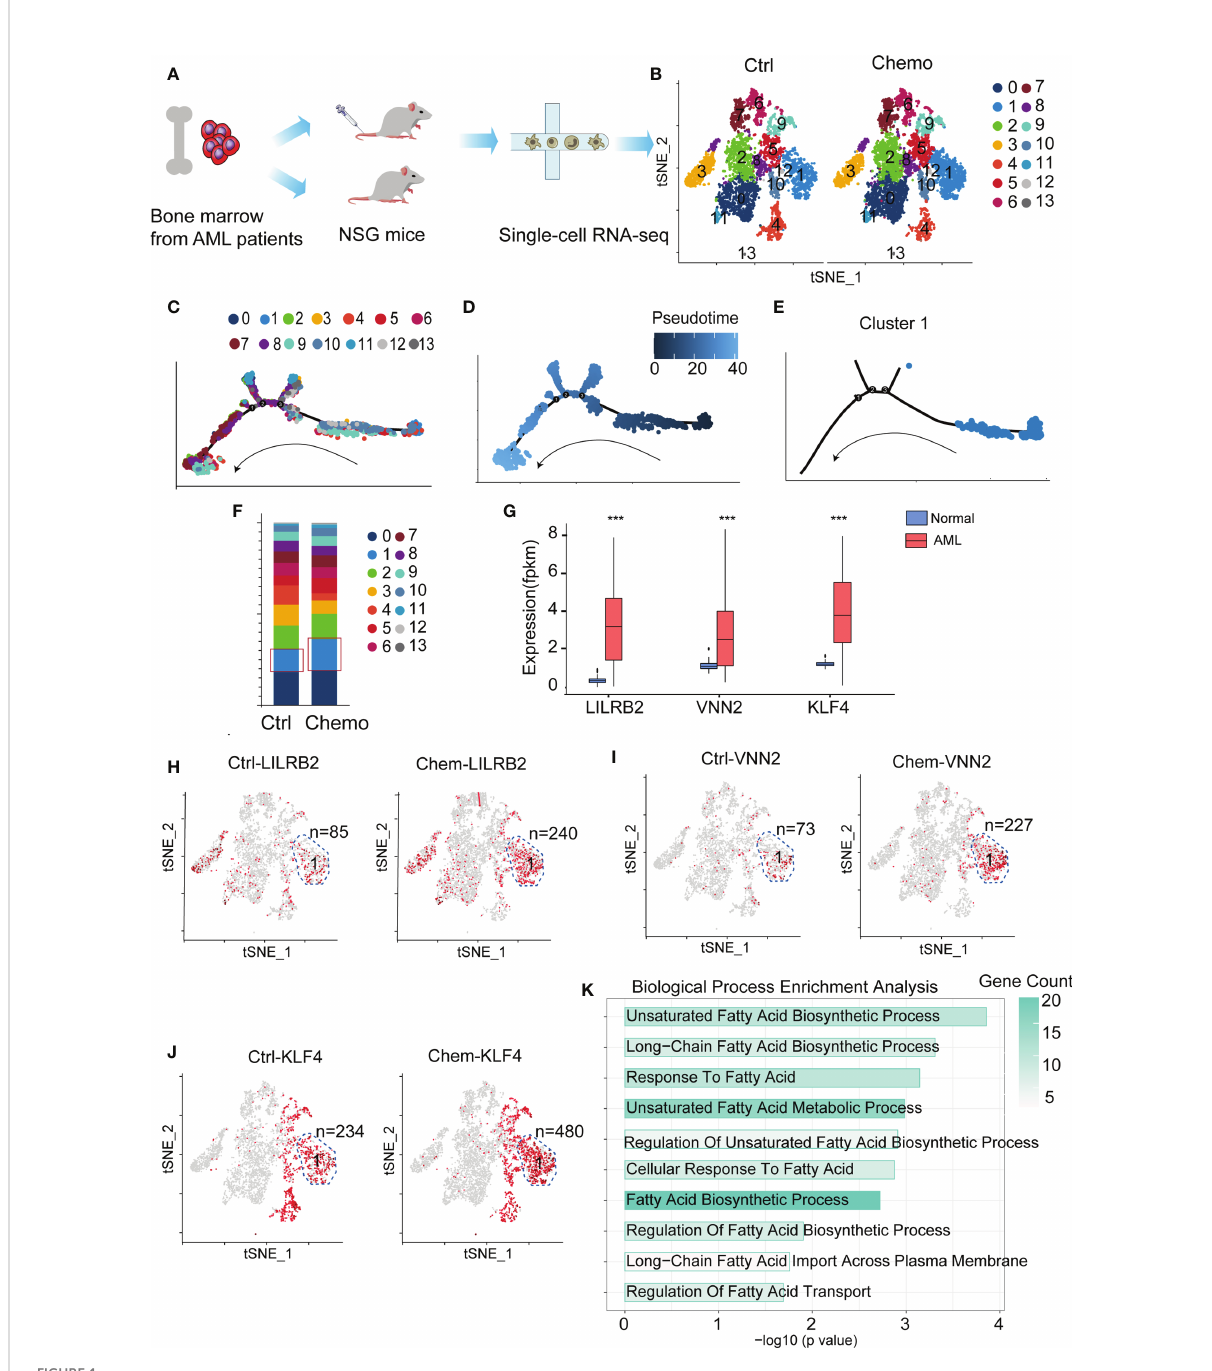
FIGURE 1 Fatty acid metabolism (FAM)-related genes are highly enriched in chemoresistant leukemic stem cells (LSCs). (A) A fl ow chart depicting the process of scRNA-Seq data acquisition. (B) Cluster the untreated (n=2 mice) and chemotherapy-treated leukemia cells (n=4 mice) with the t-SNE dimensionality reduction analysis. (C – E) The pseudotime trajectory analysis of the cells in the chemotherapy group. (F) Cell quanti fi cation of each cluster before and after chemotherapy. (G) Bar plot depicting expressions of KLF4, VNN2, and LILRB2 in AML patients and normal people. The p-value was calculated by unpaired two-tailed Student t-tests, p < 0.05, p < 0.01, p < 0.001. (H – J) LSC markers (LILRB2, VNN2 and KLF4) are enriched in the cells of cluster 1. The LILRB-, VNN2-, and KLF4-high cells are highlighted in red, and the n number depicts the red cell number in cluster 1 before and after chemotherapy. (K) GO enrichment of the upregulated genes in cluster 1. Data are displayed as speci fi c values or mean ±